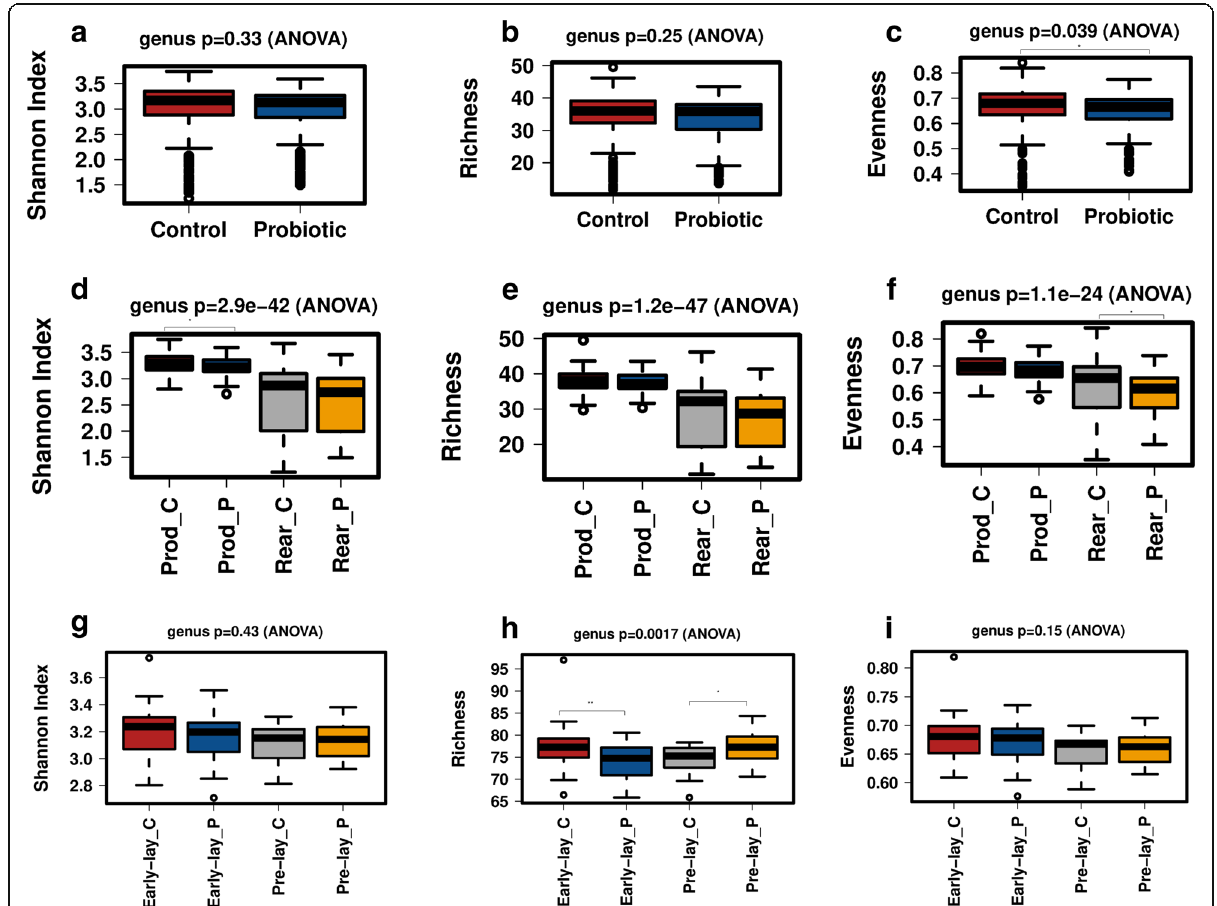
Fig. 5 Alpha diversity of gut microbiota of laying chickens affected by probiotic supplementation, rearing and laying conditions. a) . Overall diversity of the probiotic and control flocks. b) . Overall richness of taxa of samples collected from control and probiotic supplemented flocks. c) . Overall evenness of taxa of samples collected from control and probiotic supplemented flocks. d) . Overall diversity affected by the probiotic supplementation in the rearing (Rear) and production (Prod) phases of laying chickens. e) . Overall richness of taxa of samples in Rear and Prod phases of laying chickens. f) . Overall evenness of taxa of samples in Rear and Prod phases of laying chickens. g) . Overall diversity affected by the probiotic supplementation in the Pre-lay and Early-lay phases of laying chickens. h) . Overall richness affected by the probiotic supplementation in the Pre-lay and Early-lay phases of laying chickens. i) . Overall evenness affected by the probiotic supplementation in the Pre-lay and Early-lay phases of laying chickens. Within each treatment group, “ C ” and “ P ” refer to control and probiotic supplemented flocks, respectively. Alpha diversity was measured at the genus level using Shannon index, richness and evenness in Calypso software. Asterisks (*) and (**) show a significant variation in community structure of samples collected from control and probiotic supplemented groups at P <0.05 and P <0.005,